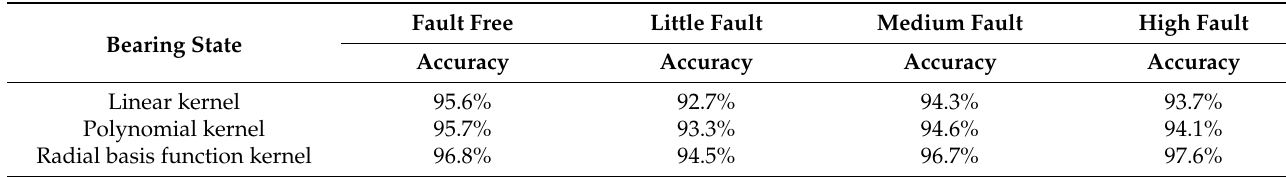
Table 7. SVM performance results based on different kernel